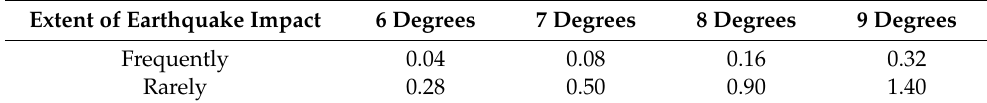
Table 8. The maximum value of horizontal seismic impact coefficient.